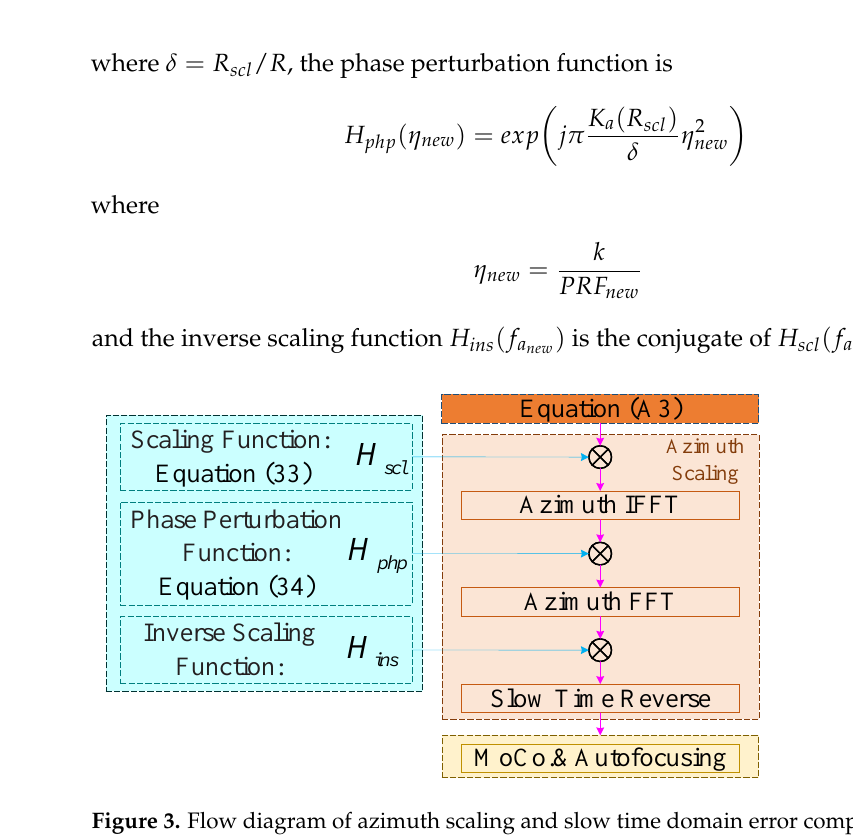
Figure 3. Flow diagram of azimuth scaling and slow time domain error